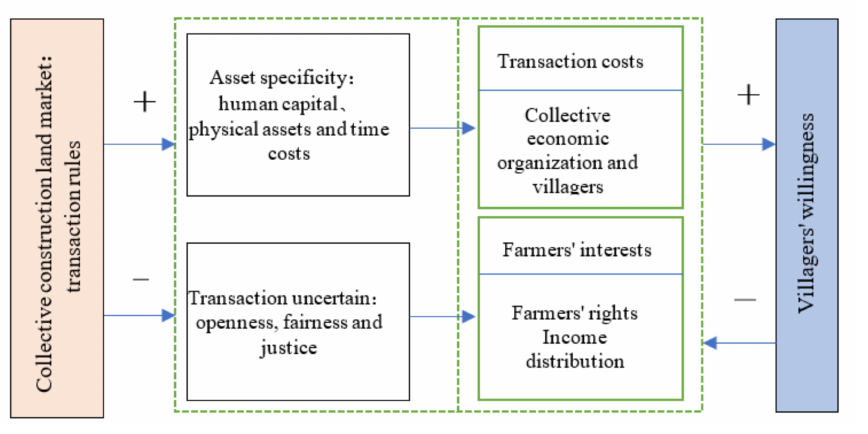
Figure 1. The theoretical